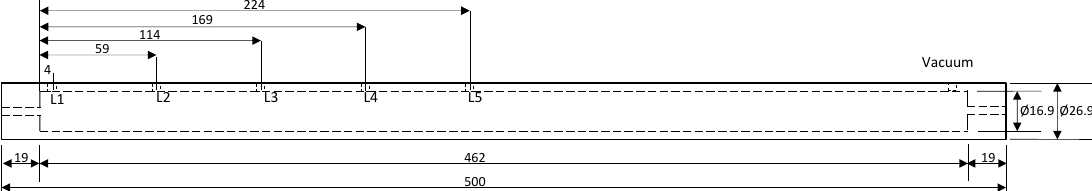
Figure 4. Drawing of the 3/4" tube of the test set-up (dimensions in mm).